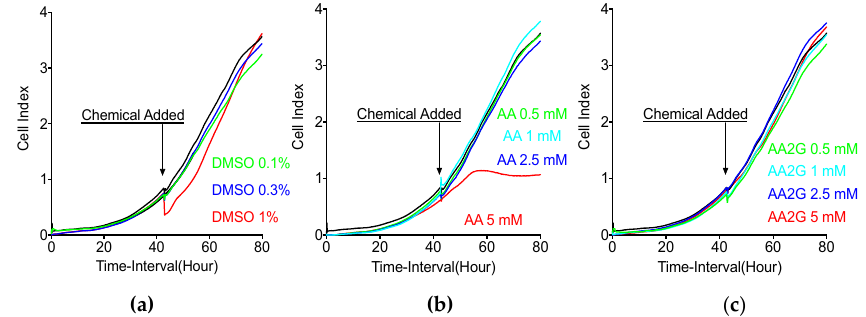
Figure 2. Dimethyl Sulfoxide (DMSO), AA and AA2G cytotoxicity measured by real-time cell electronic sensing (RT-CES) system. ( a ) DMSO ( b ) AA ( c ) AA2G, black solid line indicates control. Cell Index indicates relative cell number. Chemicals were added at 43 h after incubation. More than three experiments were carried out. Error bars were omitted.